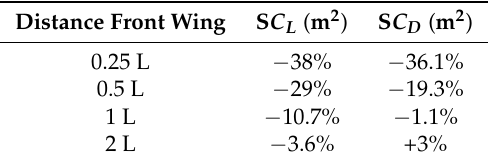
Table 7. Percentage of change of the aerodynamic coefficients in the front wing of the second car as regards the first car.